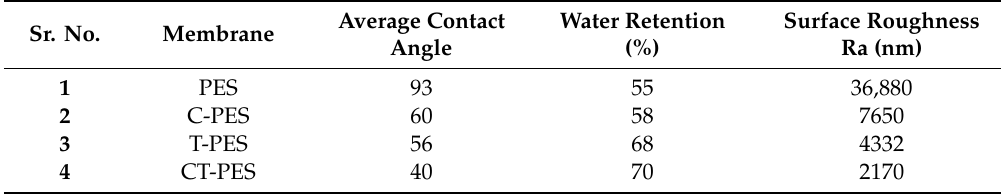
Table 3. Average contact angle and water retention and surface roughness of pure PES and hybrid membranes. Sr.